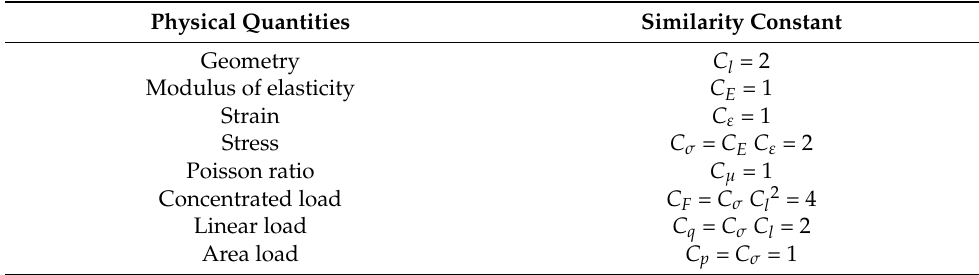
Table 1. Similarity ratios of the main physical quantities.